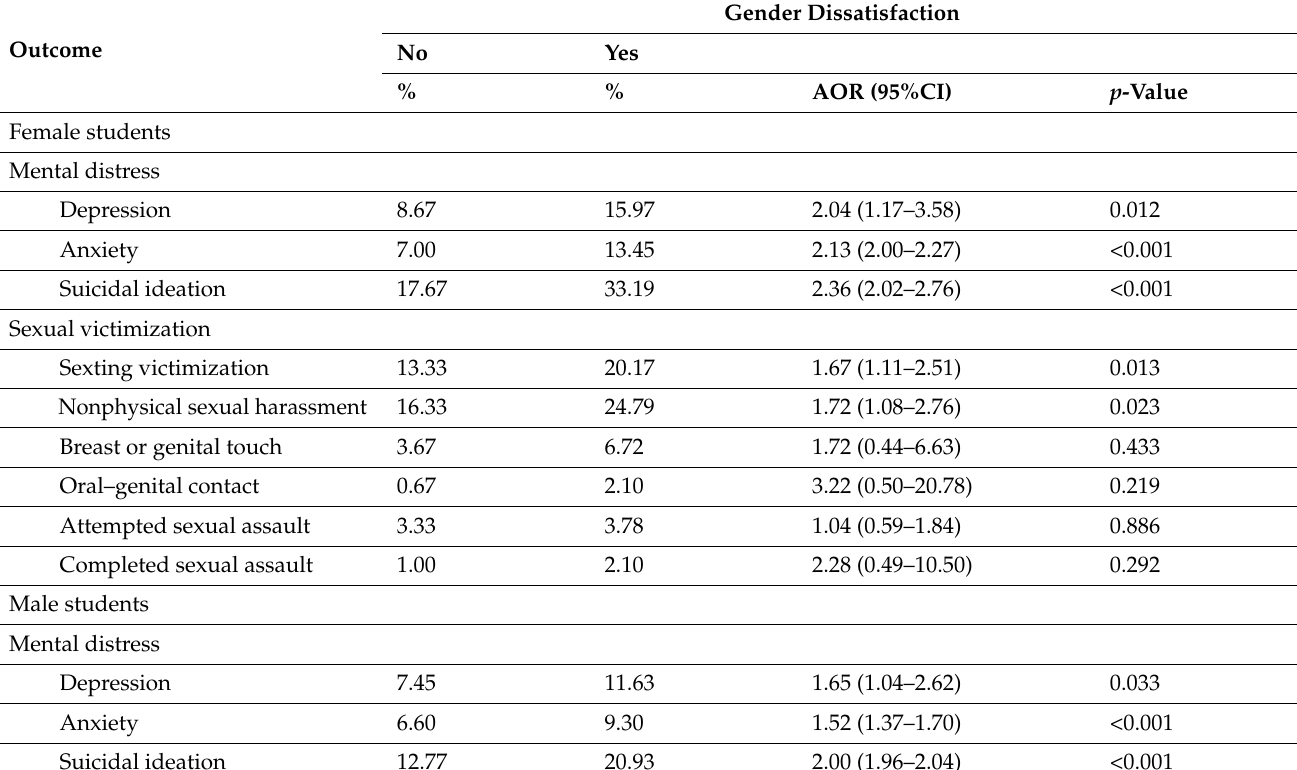
Sex-stratified associations of gender dissatisfaction with mental distress and sexual